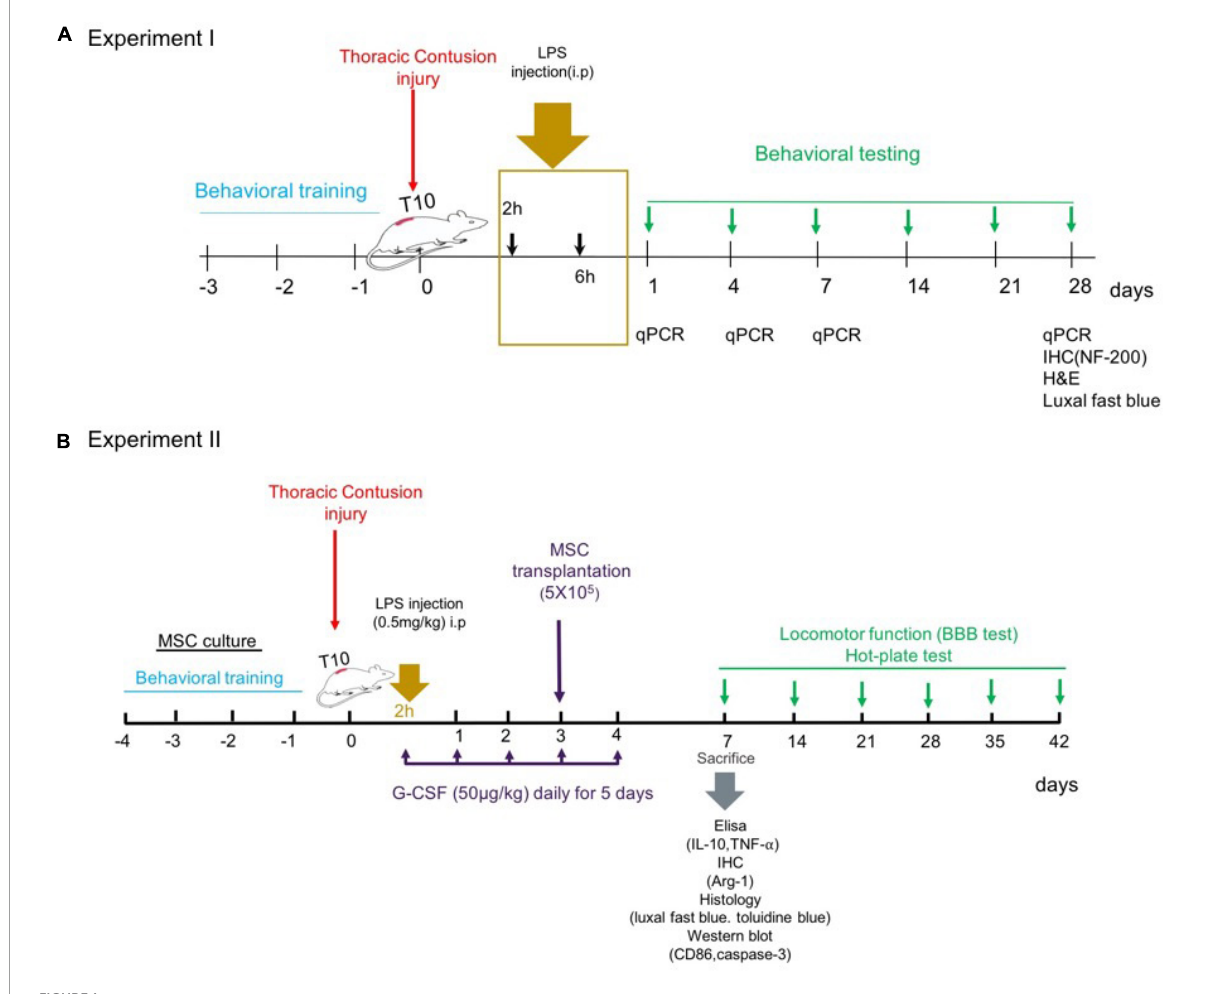
FIGURE1 Experiments timeline. (A) Experiment 1: dose–response of LPS treatment. (B) Experiment 2: combination therapy